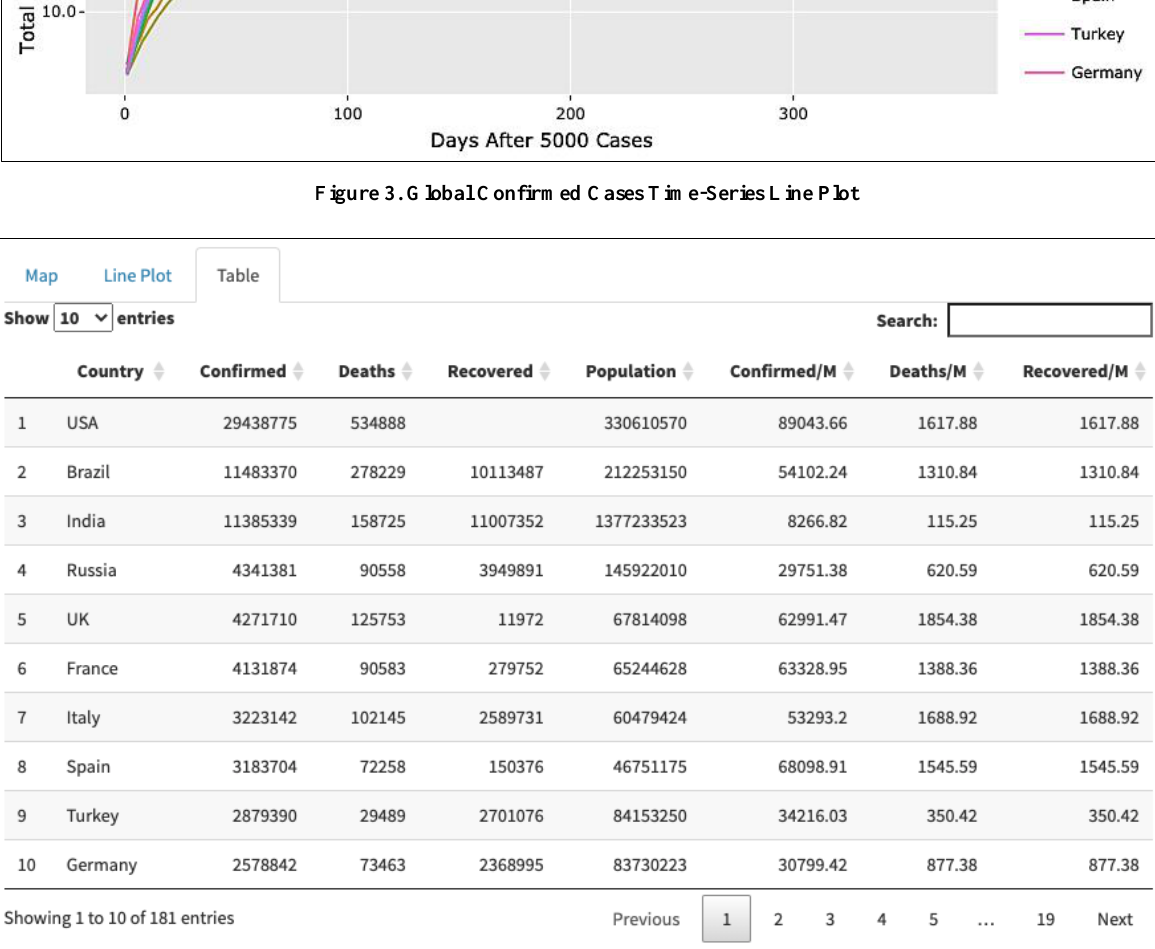
Figure 4. Global Data Table for COVID-19 Statistics by Country